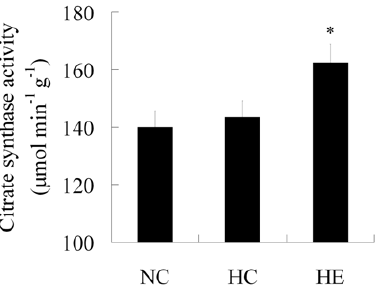
Figure 3. Citrate synthase activity in each group. Citrate synthase activity levels in the quadriceps muscle of mice from NC, HC and HE, respectively. Values are shown as means 6 SEM (n=6, each group). *:P , 0.05 vs.